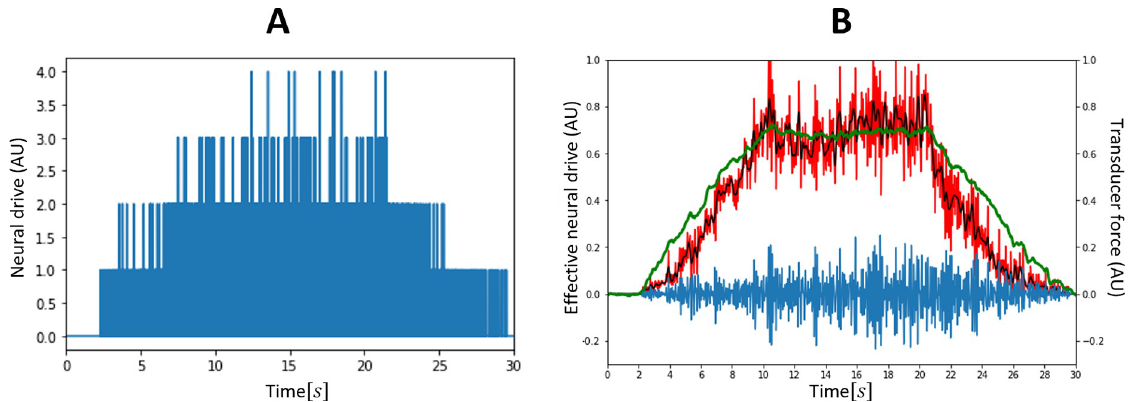
Fig 6. Neural drive to the muscle derived from the N r identified MN spike trains in the dataset DTA 35 . (A) Cumulative spike train (CST) computed by temporal binary summation of the N identified MN spike trains. (B) Effective neural drive – Upon applicability of the linearity r properties of subsets of the MN pool, the effective neural drive is assimilated as the synaptic input to the MN pool. The normalized common synaptic input (red), control (black) and noise (blue) are obtained from low-pass filtering the CST in the bandwidths relevant for muscle force generation. The normalized experimental force trace (green curve) is displayed for visual purposes.